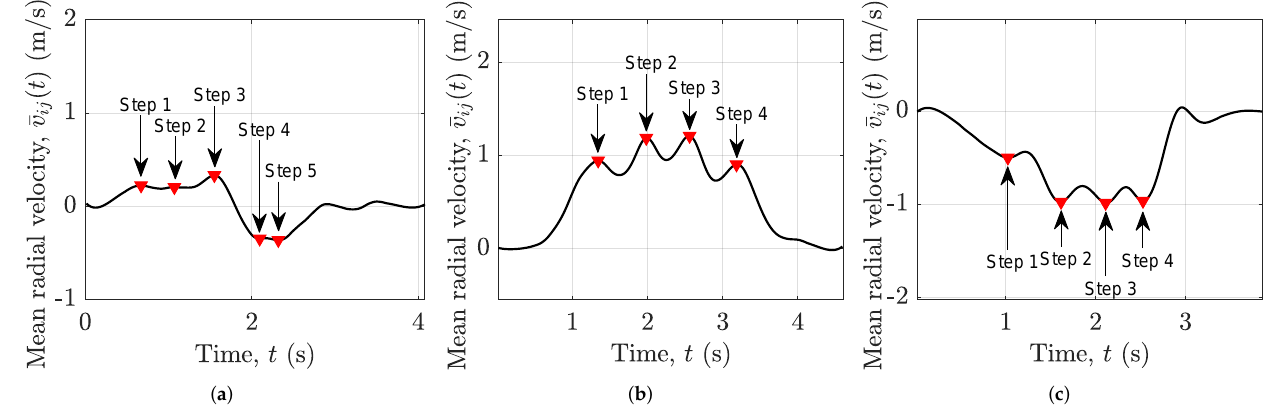
Figure 11. For Radar 2 , the number of steps detected from the smoothed mean radial velocity ¯ v 22 ( t ) of a human walking activity according to ( a ) Scenario 1, ( b ) Scenario 2, and ( c ) Scenario